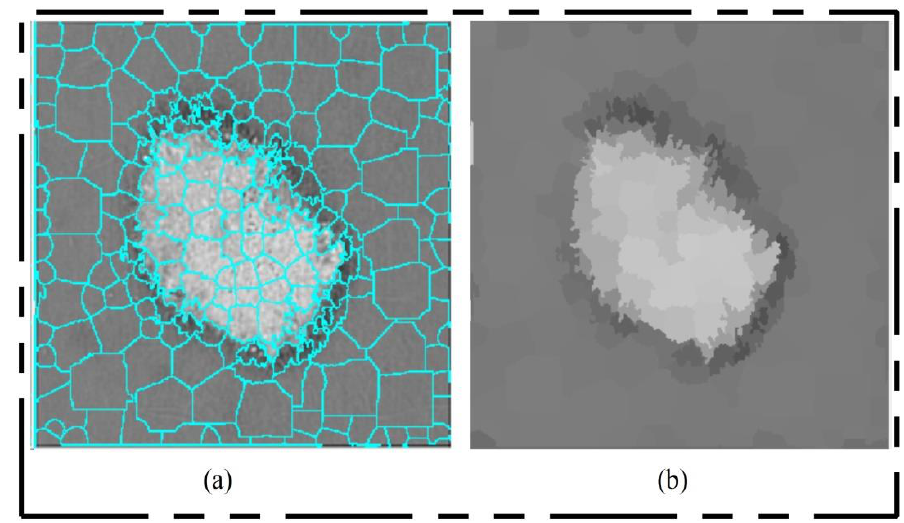
Figure 9. Superpixel generation. ( a ) Superpixel boundaries; ( b ) mean superpixel-based infected region.